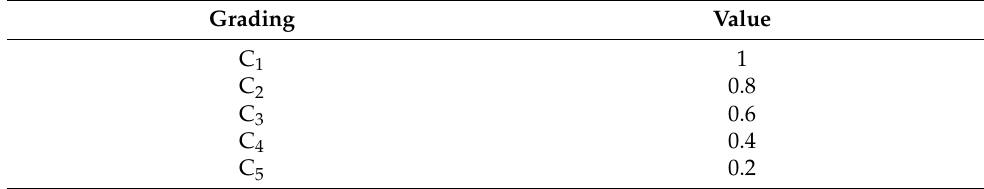
Table 5. Qualitative index grading assignment